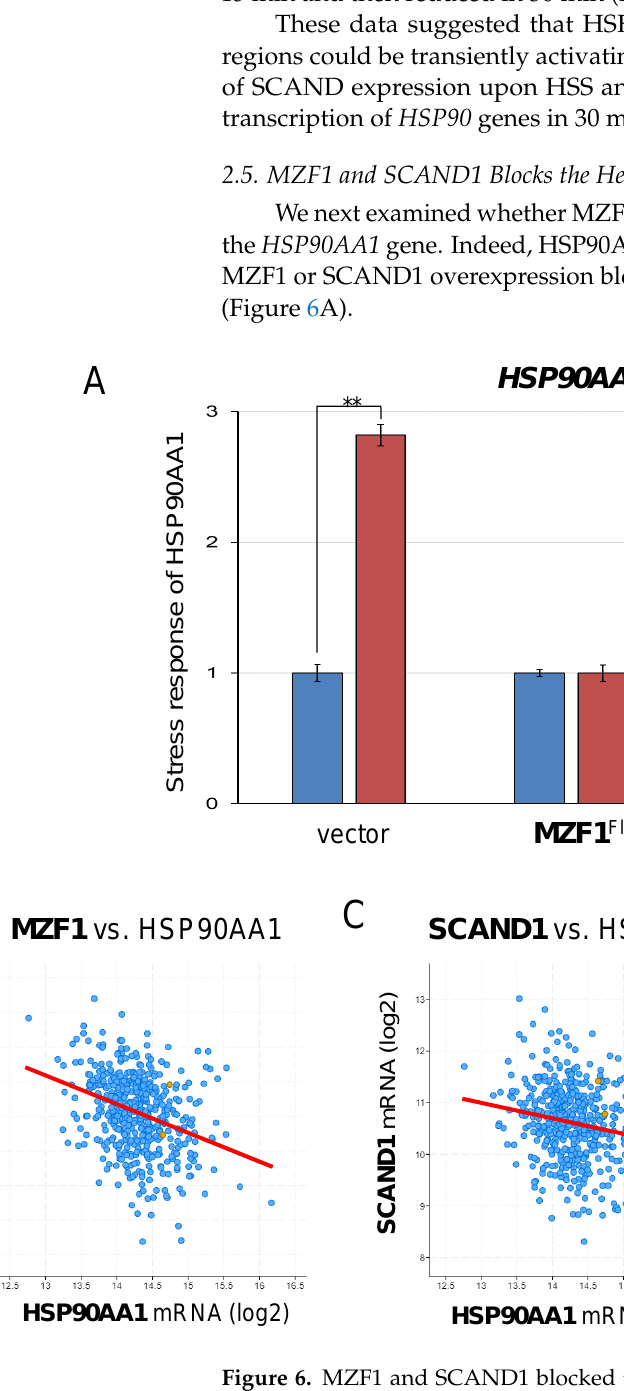
Figure 6. MZF1 and SCAND1 blocked the heat shock response of the HSP90AA1 gene. ( A ) qRT- PCR for HSP90AA1 gene. Stable DU-145 cells transfected with pcDNA3.1 vector, pcDNA/MZF1- Flag, and pCMV/SCAND1-Flag were treated with or without HSS for 30 min. ** p < 0.01, n = 3. ( B – D ) Co-expression correlation between HSP90AA1 vs. MZF1(ZSCAN6) ( B ), SCAND1 ( C ) and SCAND2 ( D ) genes in prostate adenocarcinoma (494 samples, TCGA PanCancer